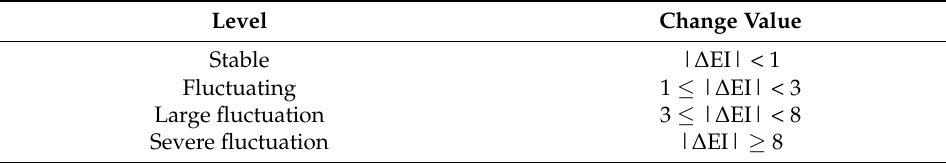
Table 8. Classification of fluctuations in ecological environment.